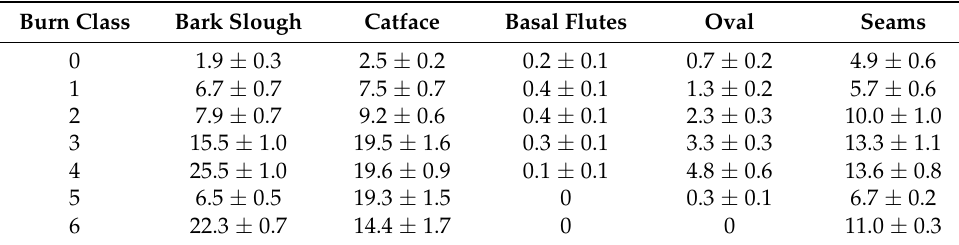
Table 5. Percentage of all trees per acre ± 1 SE to receive at least one wound of each measured type by number of prescribed fires.